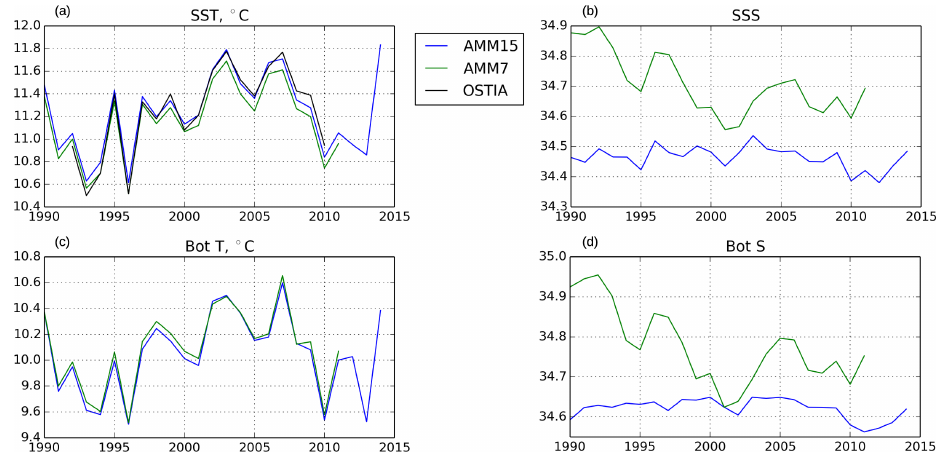
Figure 8. Annual mean temperature (a, c) and salinity (b, d) for the surface (a, b) and bottom (c, d) over the continental shelf (shaded region shown in Fig. 6). Blue and green lines show mean values for AMM15 and AMM7, respectively. For SST (a) , OSTIA CCI reanalyses (Merchant et al., 2014) are provided for